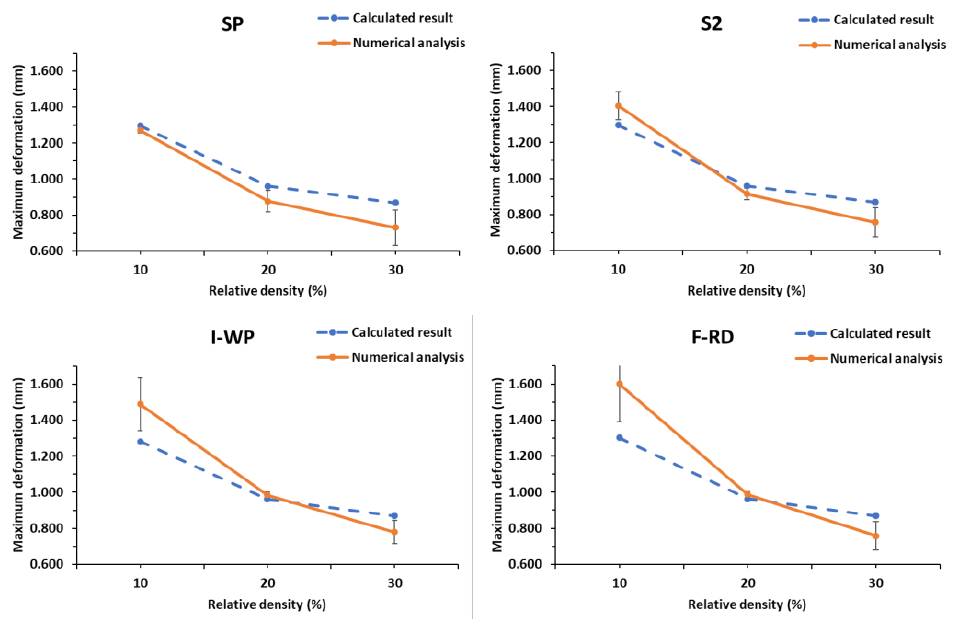
Figure 6. Comparison of maximum deformations between the calculation results and numerical predictions.